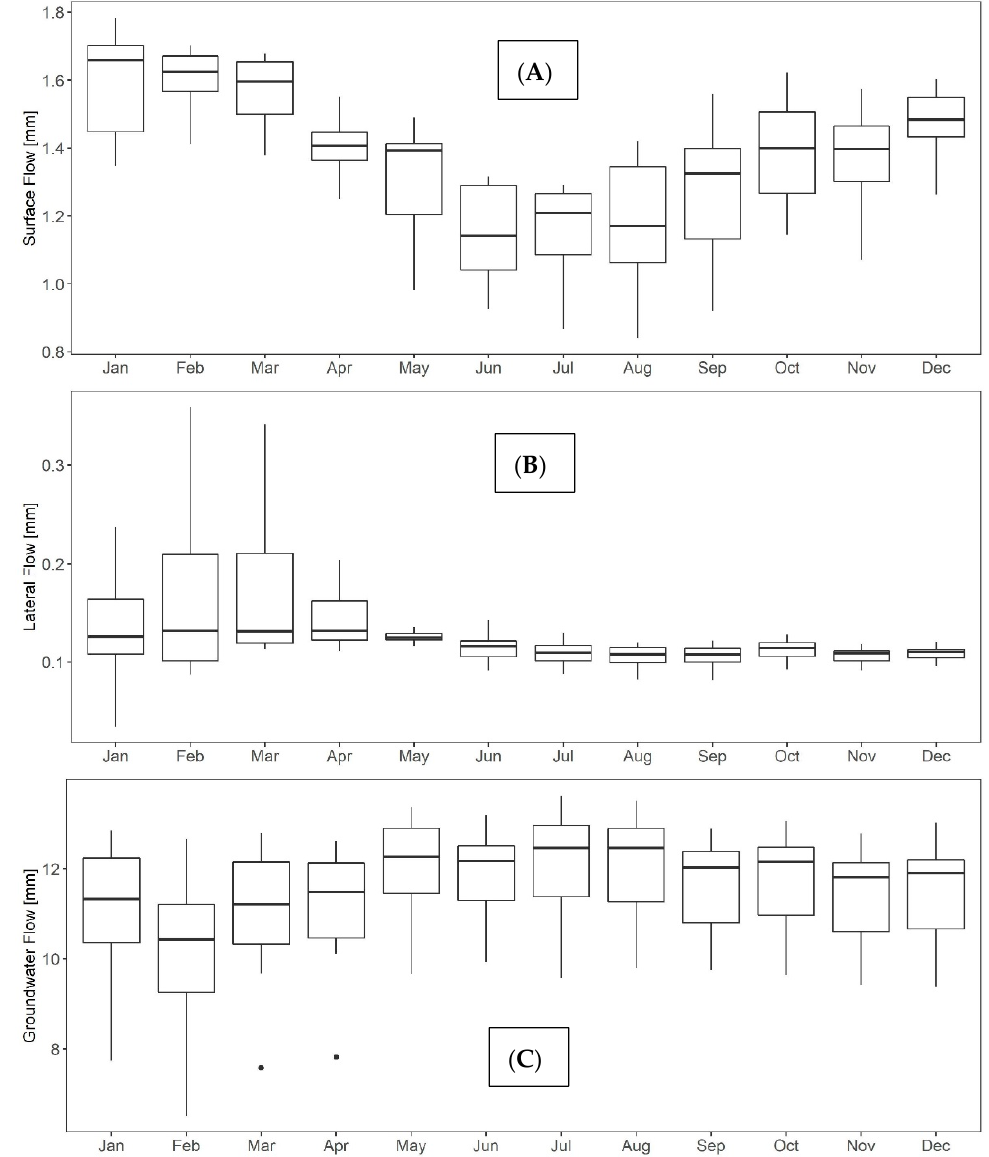
Figure 8. Box-plot showing the monthly SWAT simulated distributions of ( A ) surface flow (mm), ( B ) lateral flow (mm), and ( C ) groundwater flow (mm).